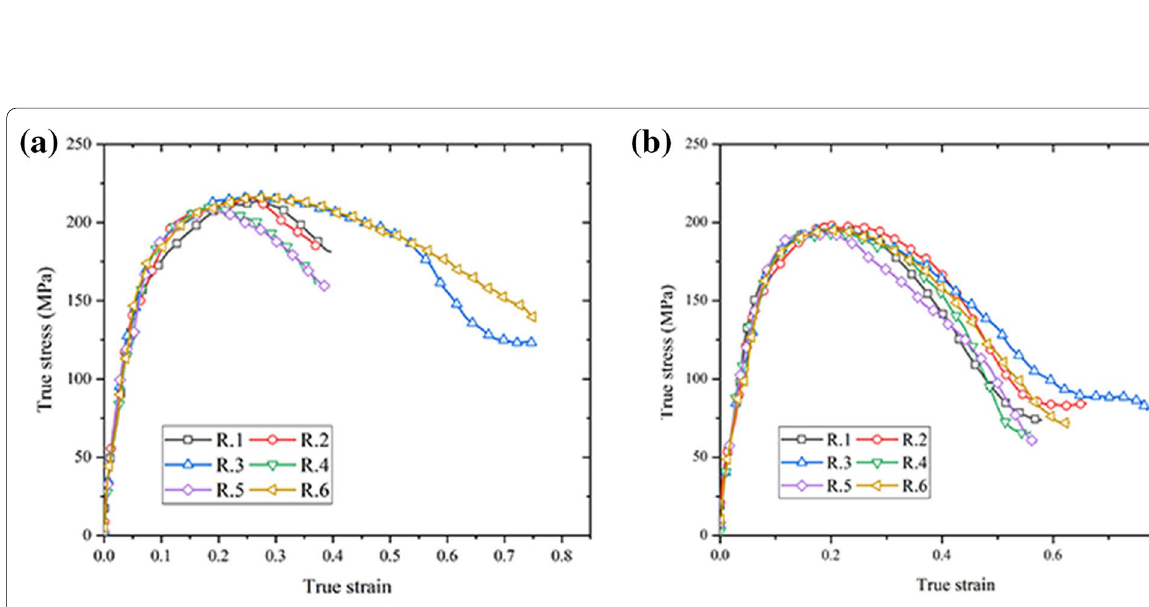
Figure 6 True stress–true strain curves of different regions at a strain rate of 15 s − 1 and at ( a ) 220 °C and ( b ) 270